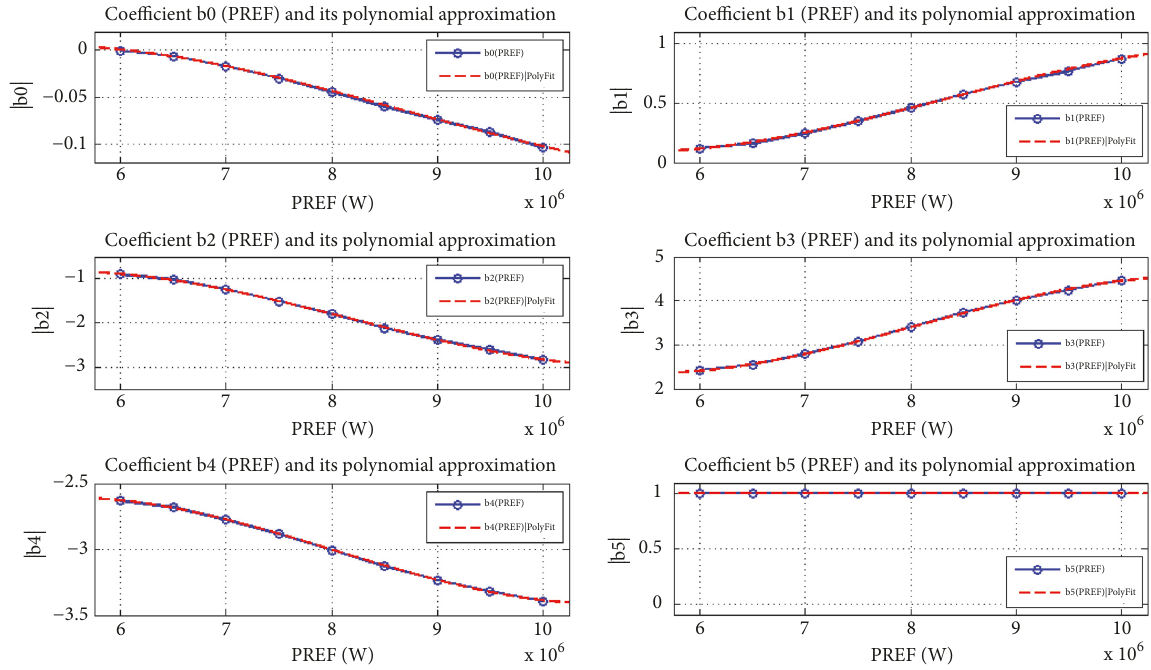
Figure 13: Design of gain scheduling controller: piecewise continuous functions of denominator of 𝑔 푐 (𝑧) and its polynomial approximation ( 3 rd ) in subresonant